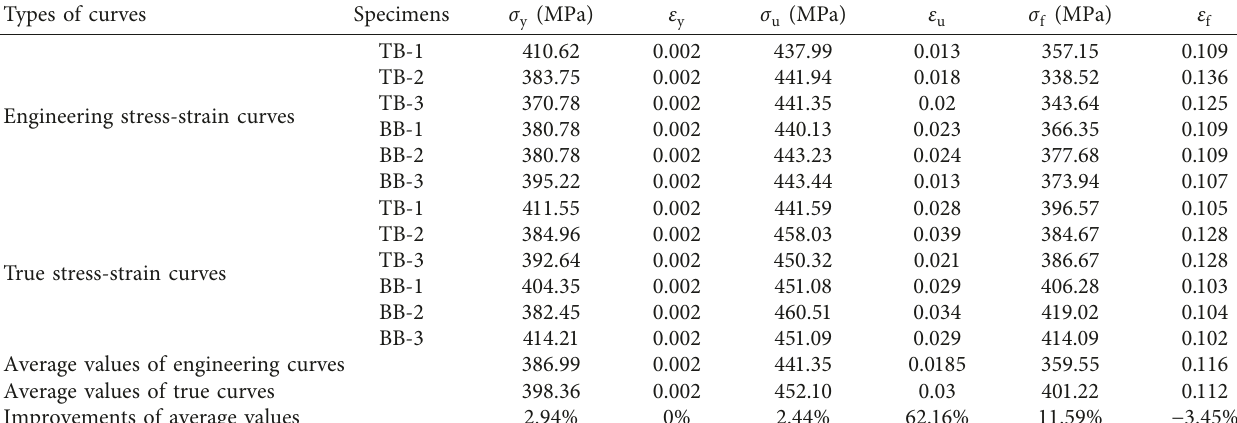
Table 3: Mechanical parameters of engineering and true stress-strain curves of corner coupons.